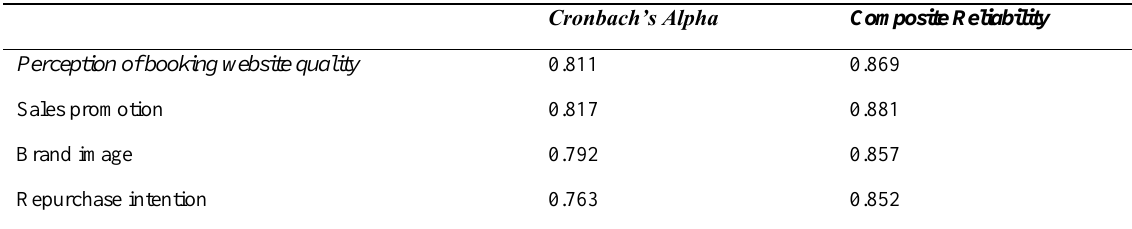
Table 4 : Reliability Analysis